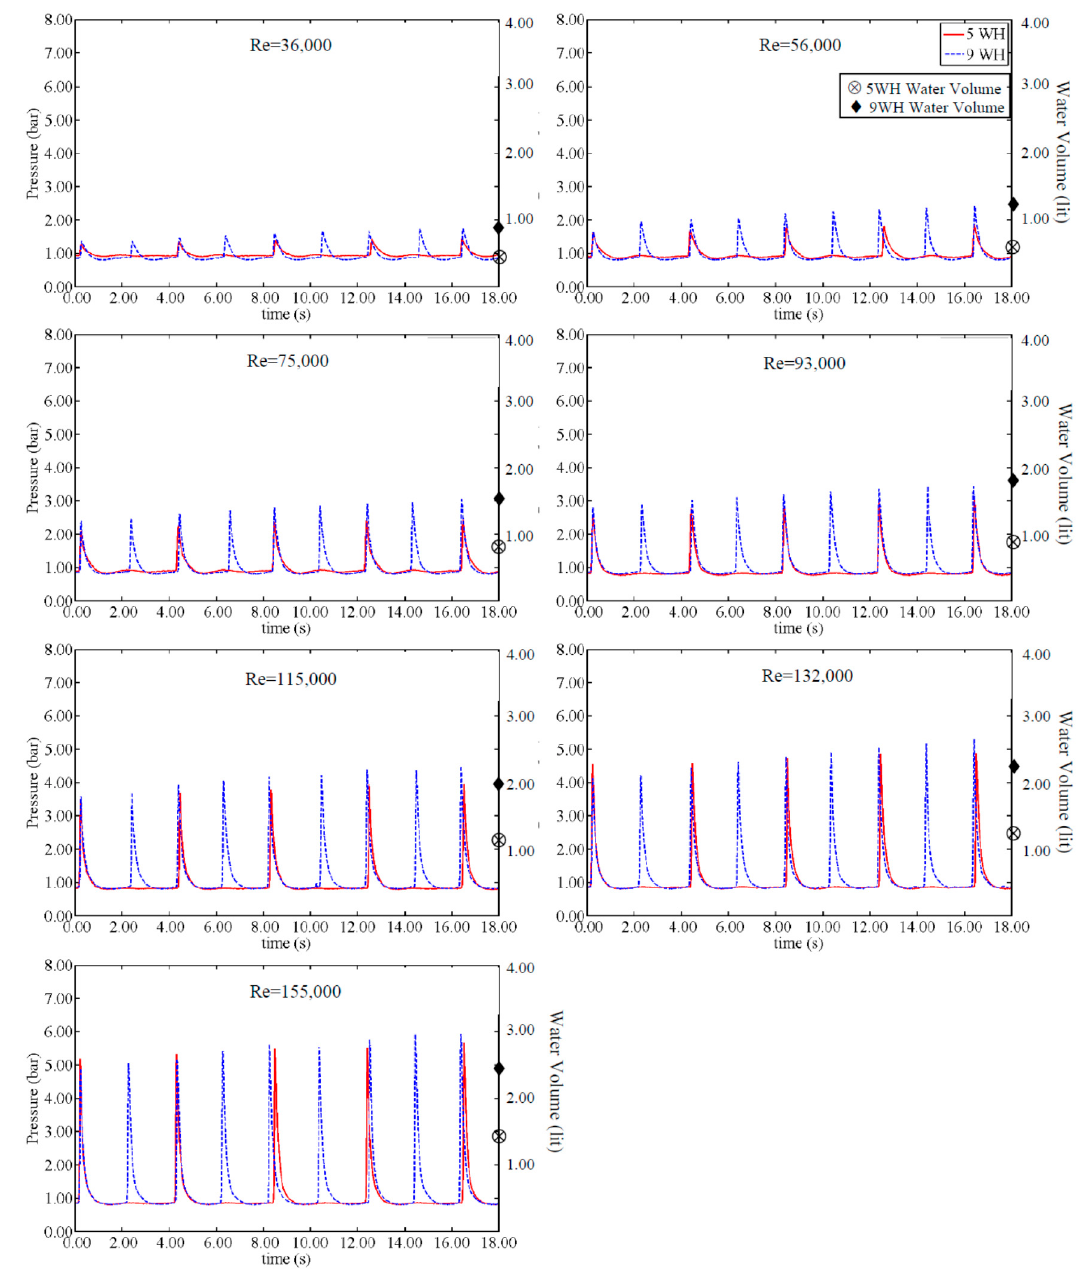
Figure 12. Pressure change in the AP and discharged water volume for 5WH and 9WH events, different Re and VFR = 4.75%.